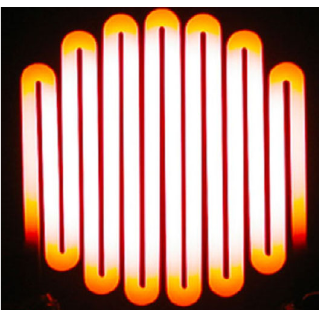
Fig. 8 Maxthal 211 heater glowing at 1723 K (3-ONE-2,